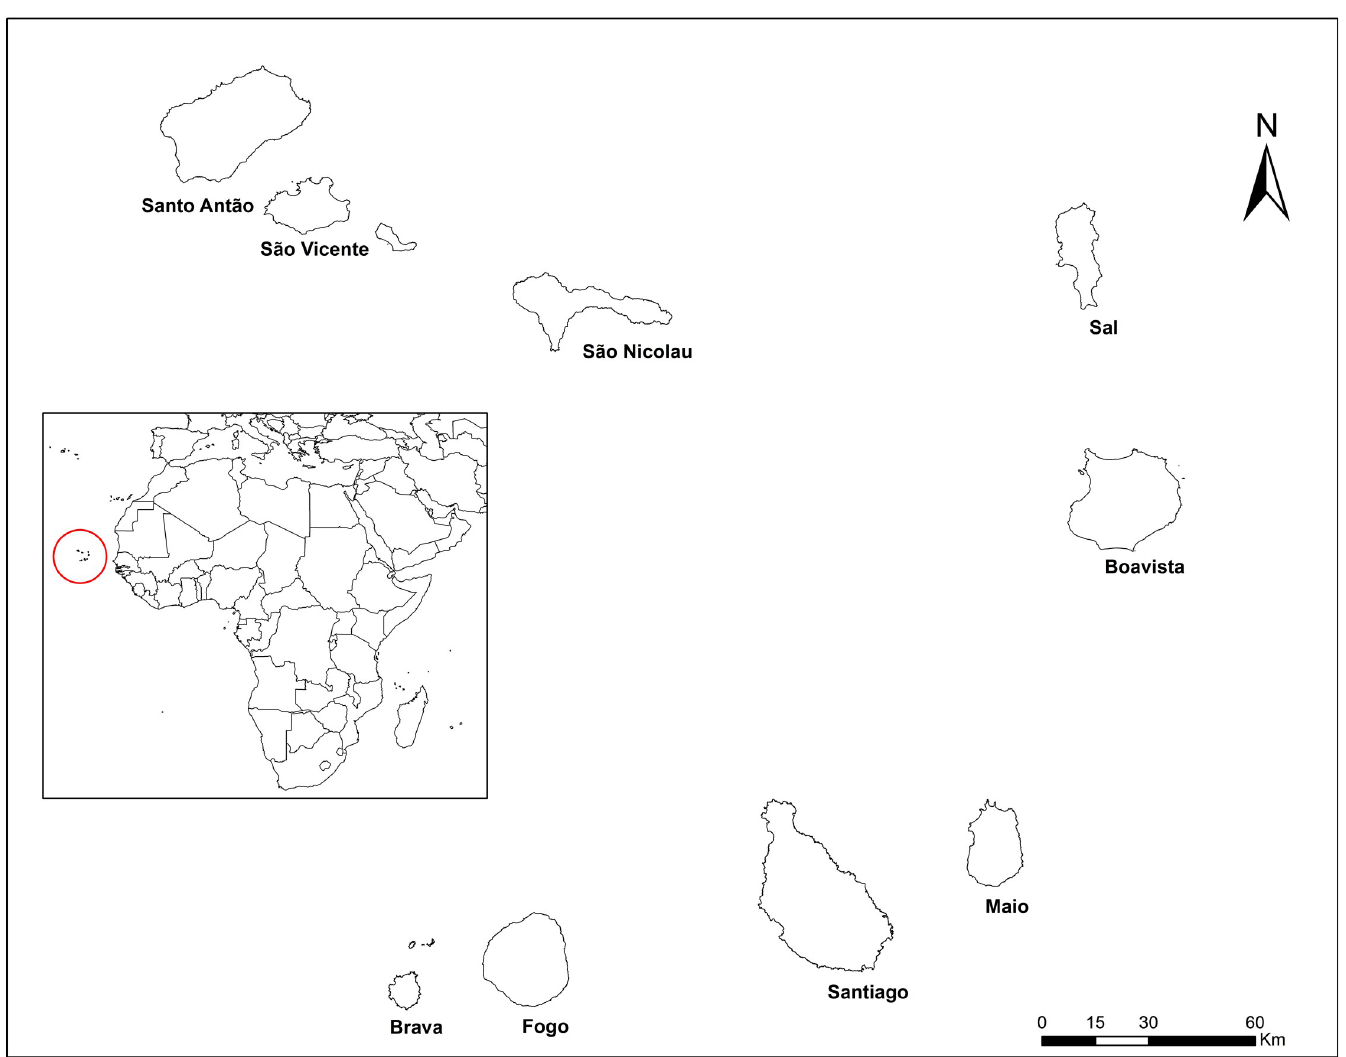
Fig 1. Localization of Cabo Verde, study